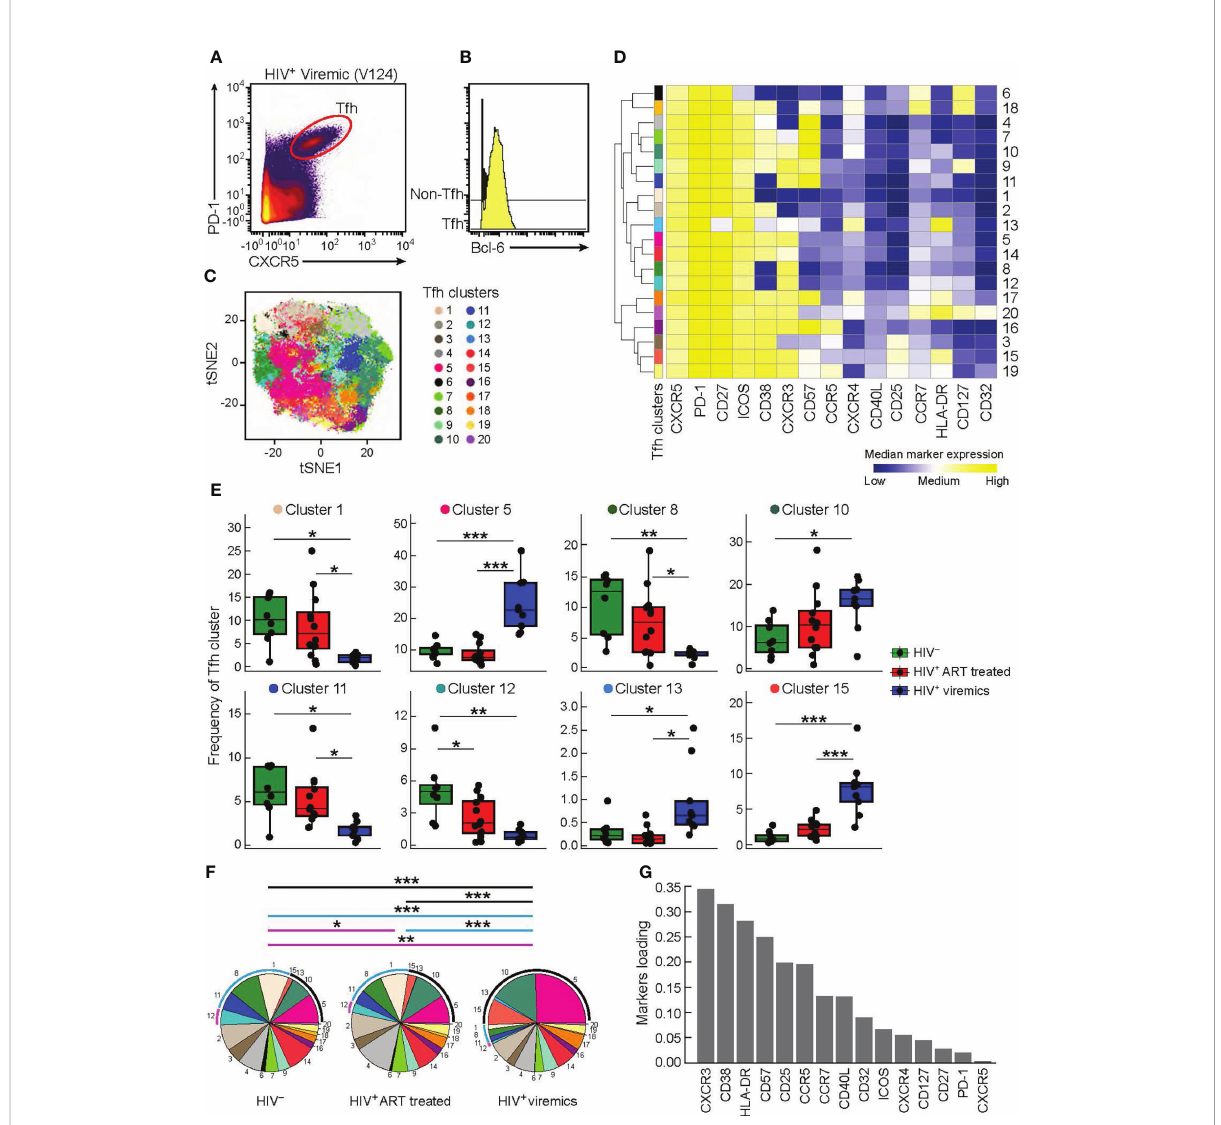
FIGURE 1 High dimensional analysis of Tfh cells in HIV infected and uninfected individuals. Mass cytometry staining was performed on LN mononuclear cells isolated from 8 HIV uninfected, 12 HIV infected HIV-infected ART treated individuals, and 9 viremic individuals. (A) Representative Tfh mass cytometry gating strategy on the basis of CXCR5 and PD-1 expression in CD45RA - CD4 + cells from representative viremic HIV infected individual and (B) BCL-6 expression on Tfh and non-Tfh cells. (C) t-SNE was performed after pooling the three study groups and gating on Tfh cells. The numbered and colored clusters Tfh clusters were obtained using FlowSOM. (D) Heat map showing median marker expression (arcsinh- transformed) of cell surface markers of the indicated clusters identi fi ed in (C) . Median marker expression values are color-coded from blue (low) to yellow (high) and the branching on the left of the fi gure represent how related the populations are according to the marker expression. The height of the branches are proportional to the distance. (E) Frequency of Tfh clusters that are signi fi cantly different between the three groups (HIV uninfected (green), HIV-infected ART treated individuals (red) and viremic (blue) individuals). (F) Pie charts representing frequencies of Tfh clusters in HIV uninfected, HIV-infected ART treated individuals and HIV-infected viremic individuals. Arcs show frequencies of clusters that are signi fi cantly different between HIV uninfected, HIV-infected ART treated individuals and HIV-infected viremic individuals. (G) Bar plot showing the relative contribution of markers to Tfh clusters heterogeneity. (Y-axis: average marker loadings in the fi rst two principal components of a PCA). P values were obtained by linear regressions and corrected using FDR method with a cutoff of 0.05. * P < 0.05, ** P < 0.01, *** P <